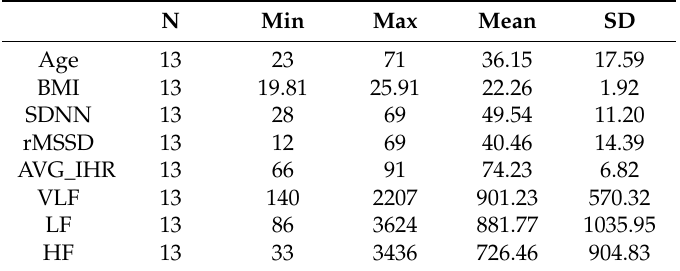
Table 1. Sample characteristics and heart rate variability (HRV) baseline values. N